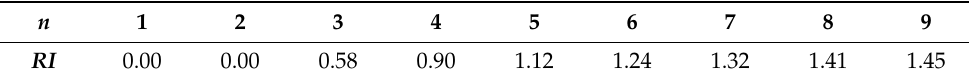
Table 1. Matrix consistency judgment index